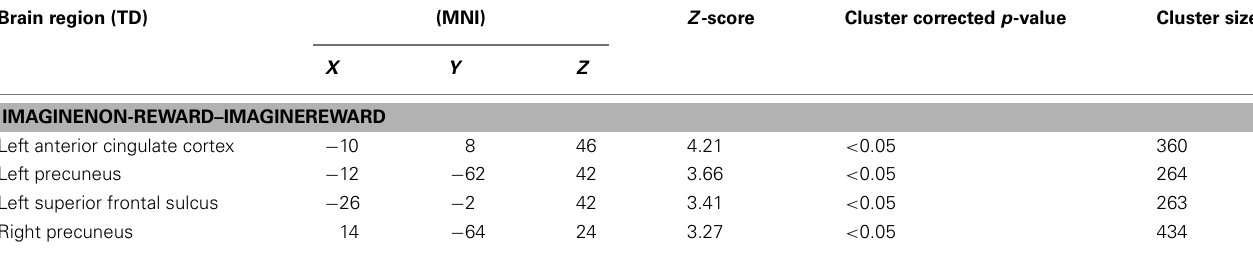
Table 1 | Summary of activations for whole-brain analysis. Coordinates are reported in MNI space, and cluster size is given in number of contiguous voxels. All reported activations pass a cluster-corrected threshold of p <